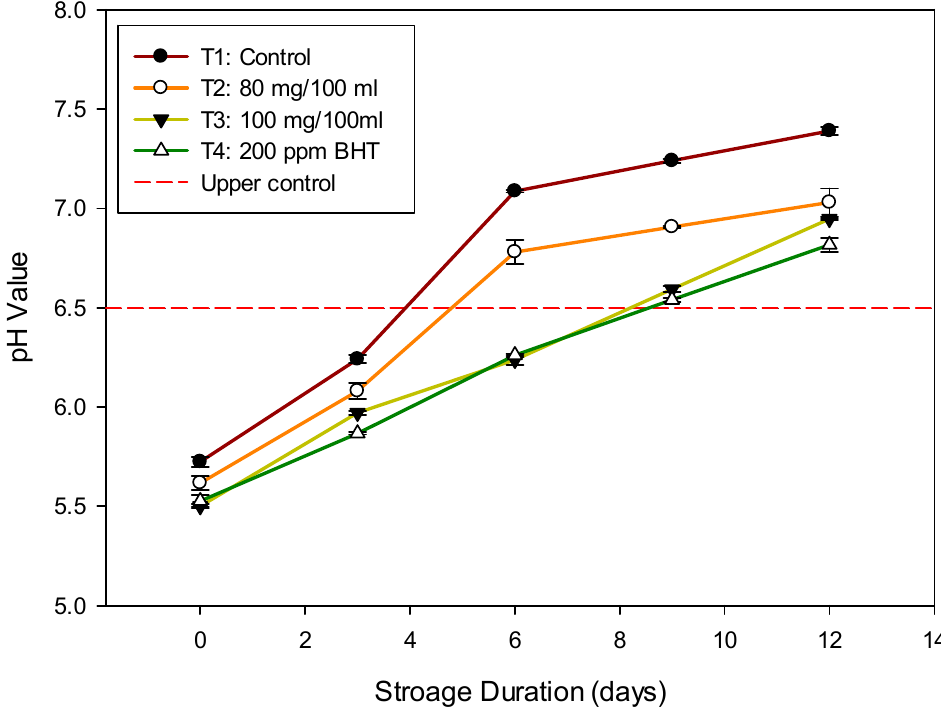
Figure 2. pH values of Nile Talipia fillets treated with DRBP during storage for 12 days at 5 °C. 3.5. Changes in Thiobarbituric Acid (TBA) Value of Nile Tilapia Fish 3.5. Changes in Thiobarbituric Acid (TBA) Value of Nile Tilapia Fish Fillet